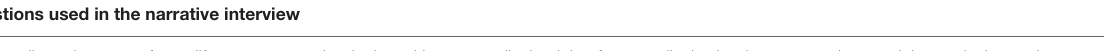
TABLE 2 | Questions used during interviews.